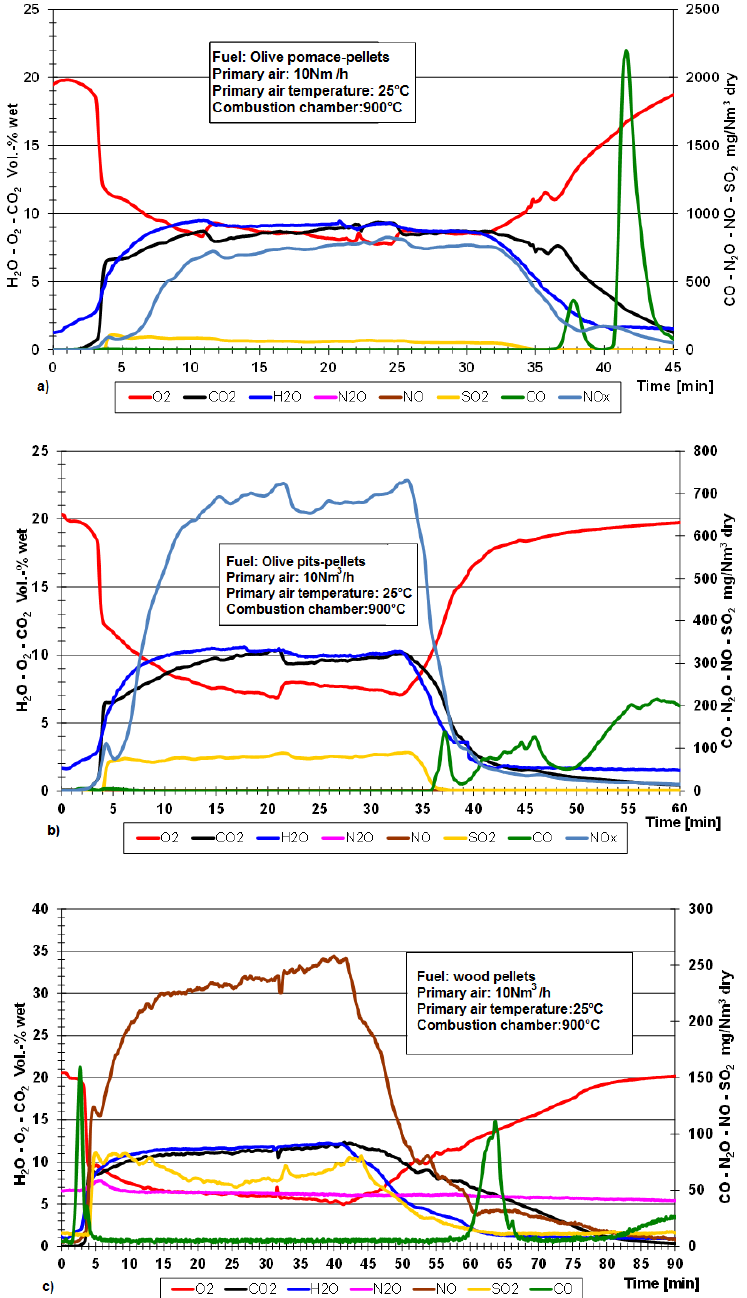
Figure 7. Traces of gases measured at the outlet of the post-combustion chamber ( a ) 100% OP; ( b ) 100% OP i and ( c ) wood pellets.